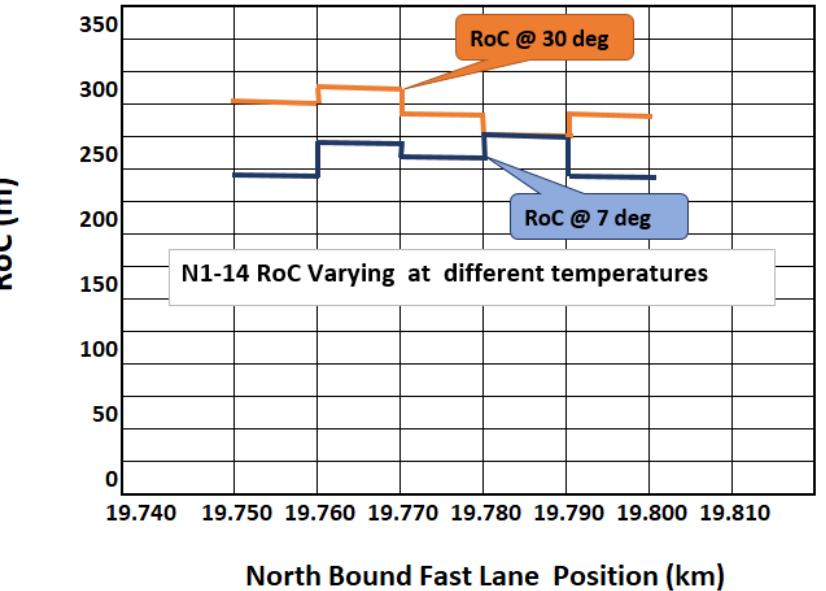
Figure 6. Variance in RoC at different times of the day and associated different temperatures [4].